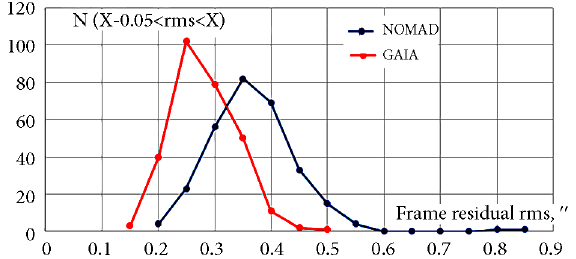
Figure 4. Distribution of reference star residual rms for a session of 300 frames – comparison of GAIA